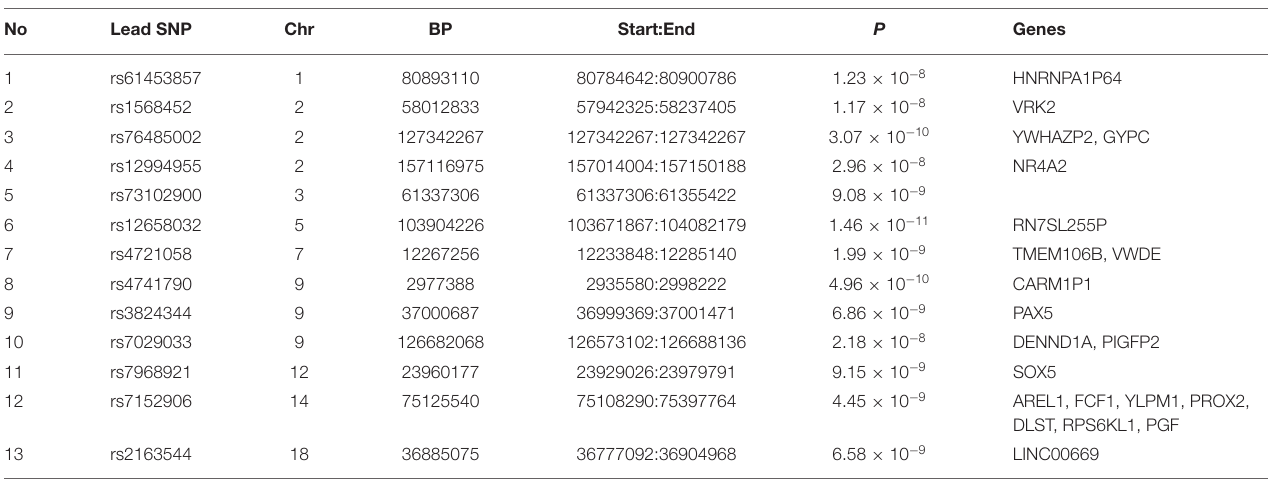
TABLE 3 | Genomic loci shared between major depressive disorder and